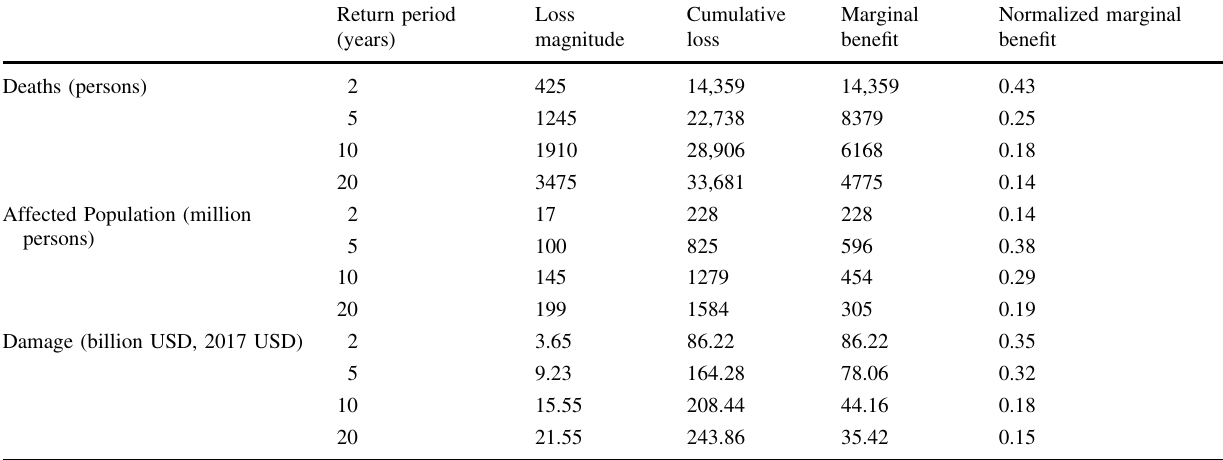
Table 1 Marginal benefit chart for loss prevention levels of China